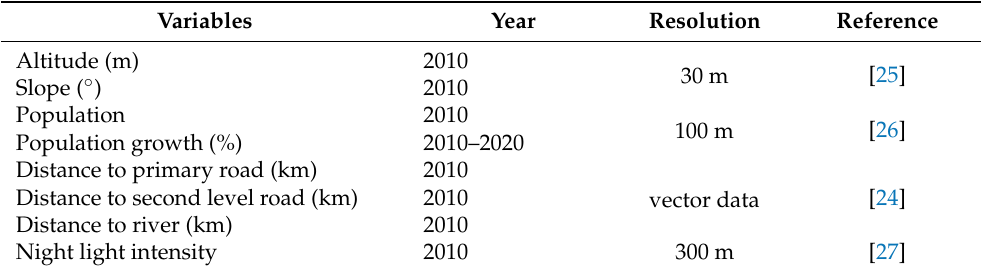
Table 1. Variable system for evaluation land suitability. Variables